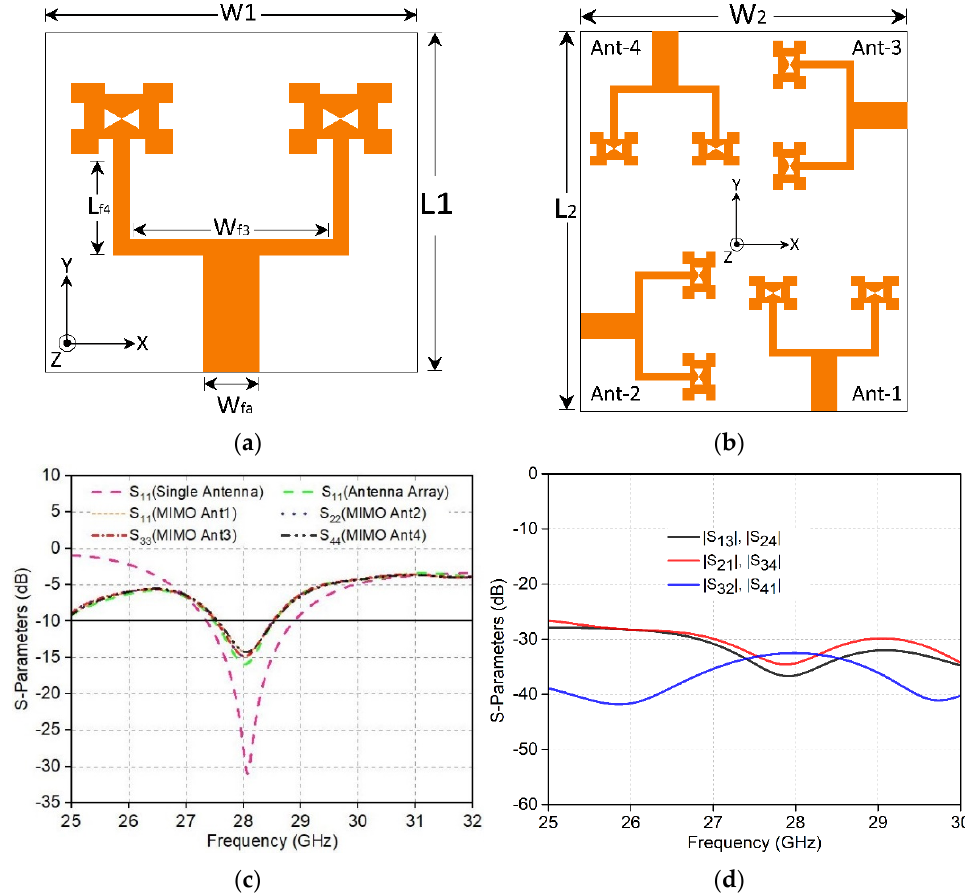
Figure 5. ( a ) Antenna array; ( b ) MIMO layout; ( c ) Reflection coefficient; ( d ) Transmission coefficient.